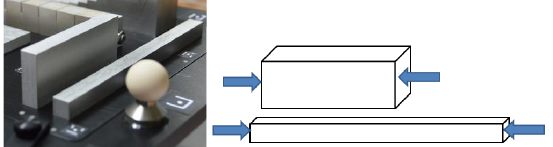
Table 1. Overall values of team for Sphere Diameter error.